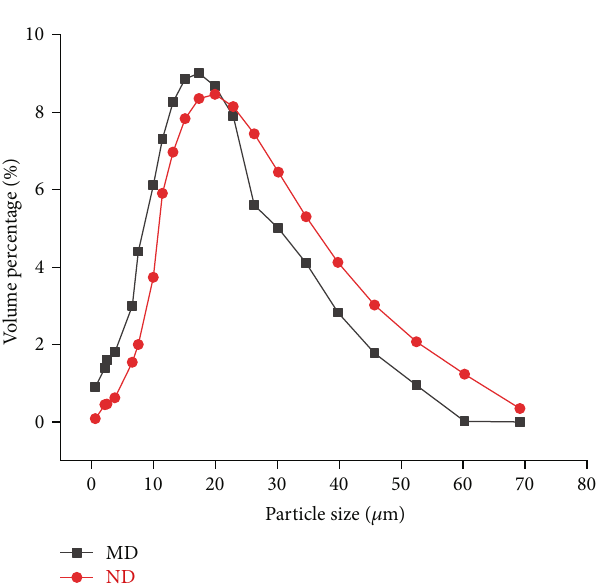
Figure 4: Particle size distribution of MD and ND.